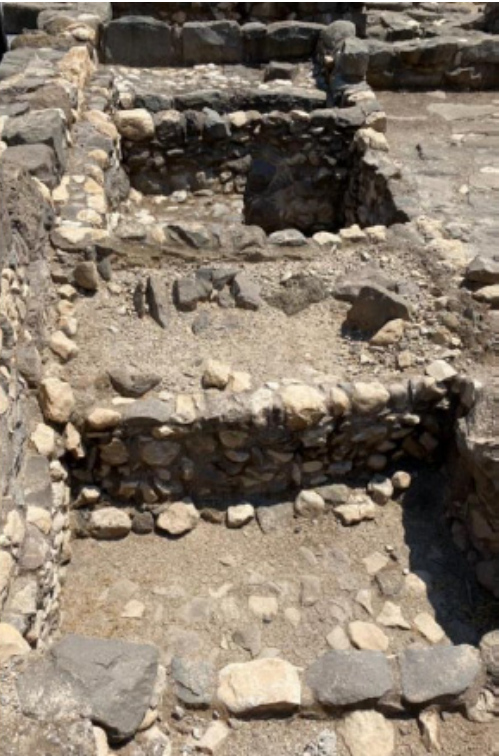
Figure 7. Magdala archaeological site, Salting Pools, 1st Century (photo: Assaf Pinkus).